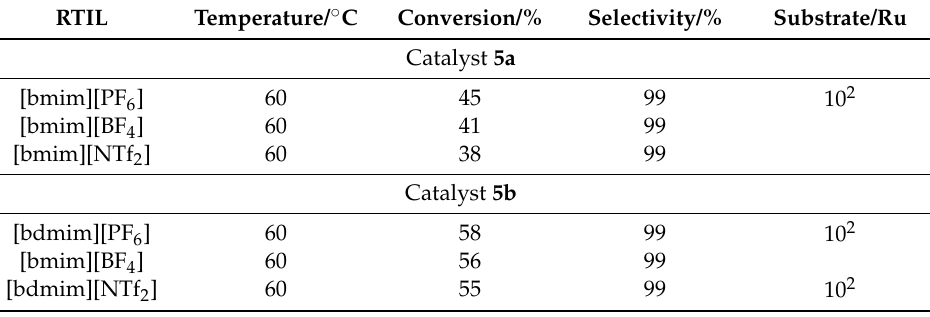
Table 3. Activity and selectivity of Hoveyda-Grubbs catalysts 5c and 5d on methyl ricinoleate in ILs. RTIL Temperature/°C